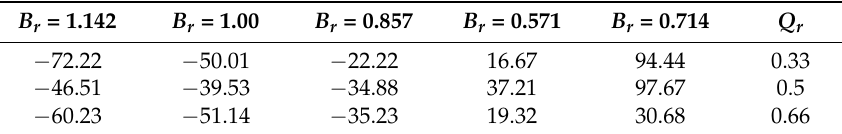
Table 5. Change (%) of ds / B 3 for different widths as compared to Br = 0.428.